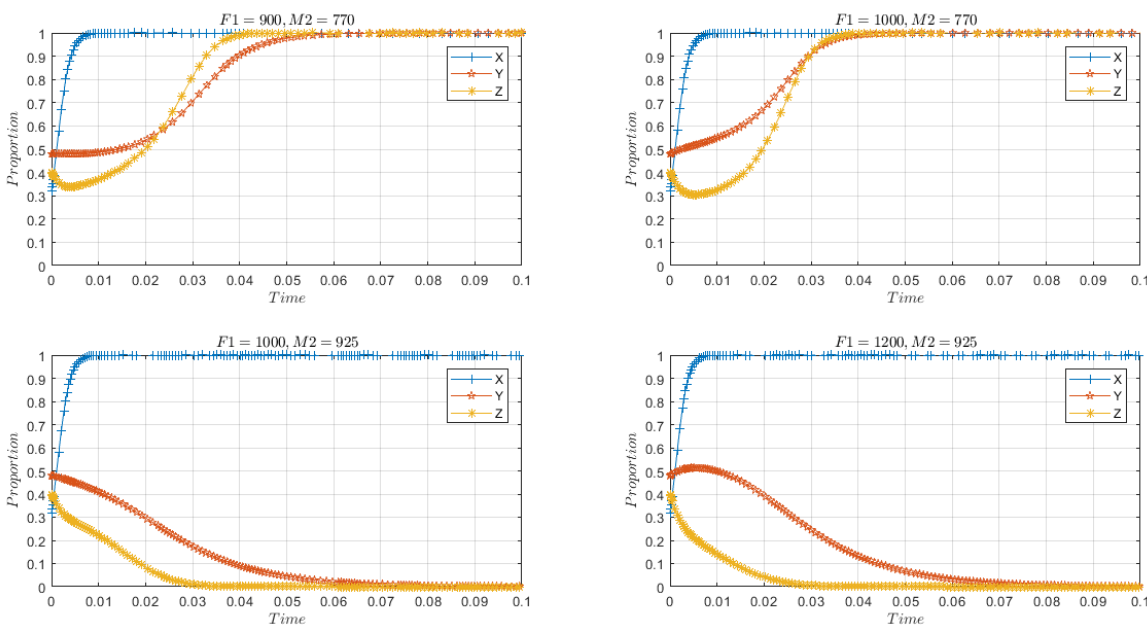
Figure 10. Evolution path of each stakeholder in System A under the influence of F 1 and M 2.